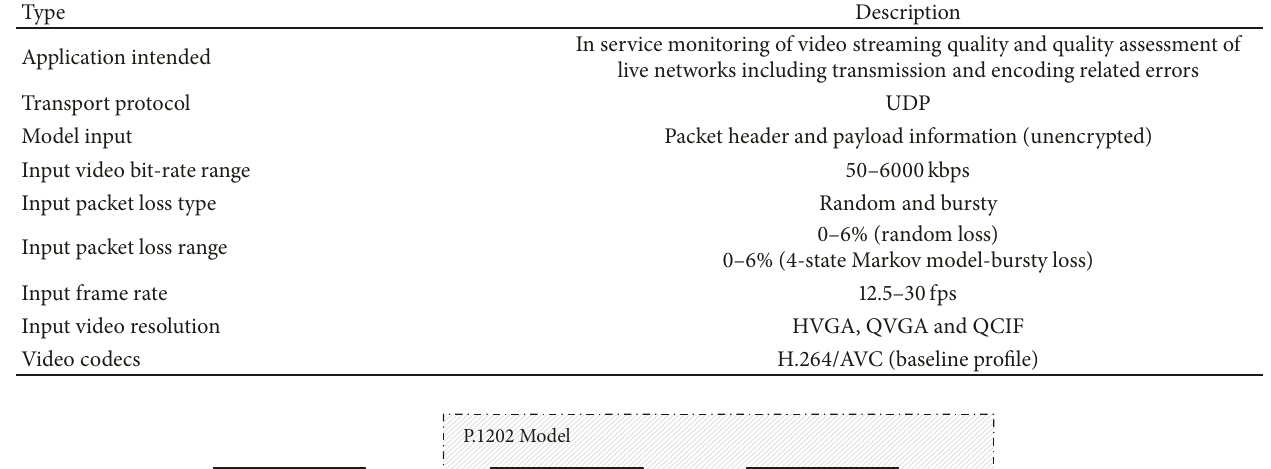
Table 10: Application areas, test factors, and technology used by the ITU-T P.1202.1 model.